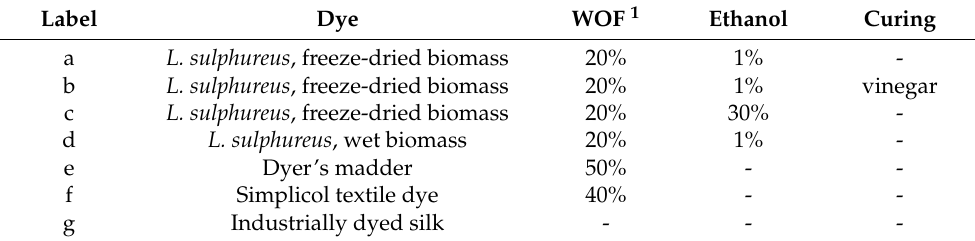
1 Weight of Fiber (WOF): Amount of dyestuff used, given as the ratio of fiber.